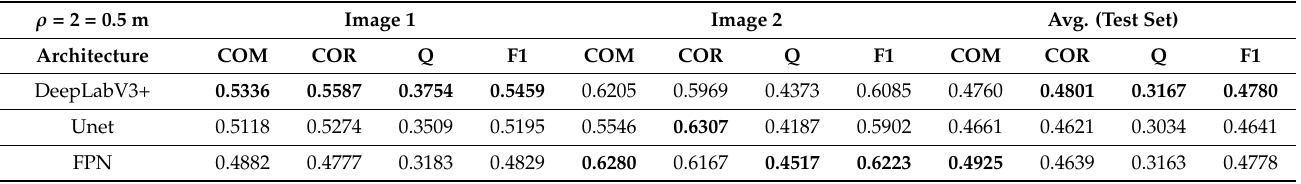
Table 6. Rural road extraction quantitative results for a ρ = 2 (using the Guo–Hall thinning